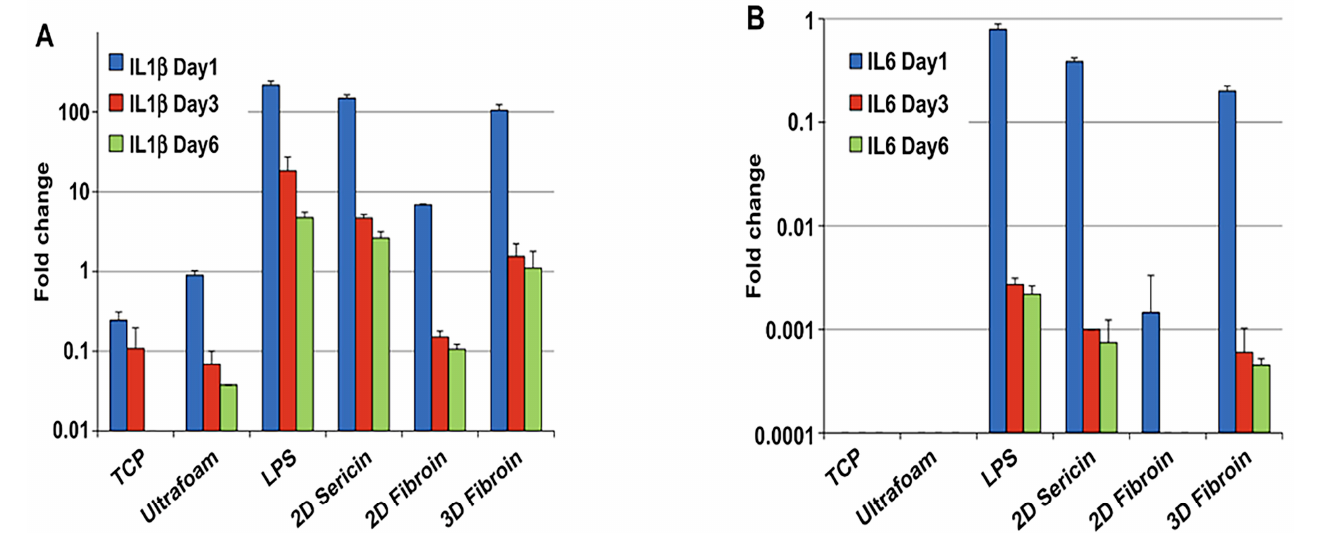
Figure 3. Monocyte responsiveness to silk-based biomaterials with different physic-chemical char- acteristics: cytokine gene expression. ( A ) Gene expression of IL-1 β . ( B ) Gene expression of IL-6. Reproduced with permission from [83]. Copyright © 2013 Published by Elsevier